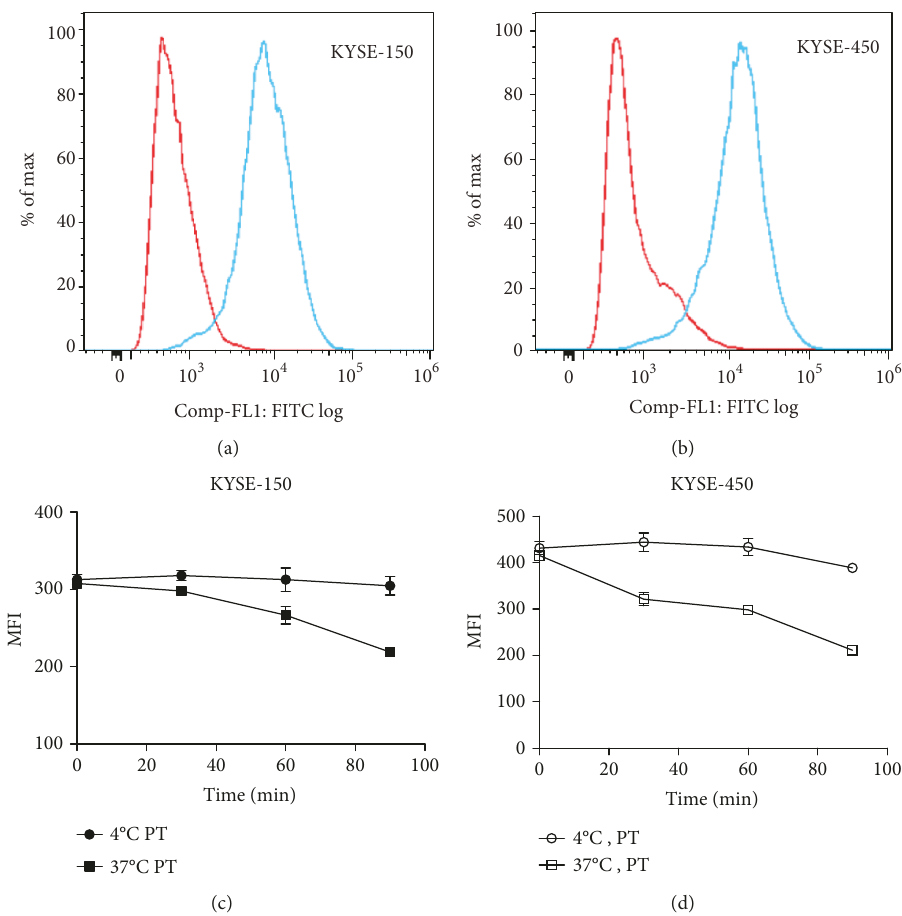
Figure 2: PT was rapidly internalized when bound to EGFR-overexpressed esophageal cancer cells. (a) Flow cytometric results, indicating cell surface EGFR expression in KYSE-150 cell lines. (b) Flow cytometric results, indicating cell surface EGFR expression in KYSE-450 cell lines. (c) Analysis of internalization rates of PT in KYSE-150 cells when binding to EGFR. (d) Analysis of internalization rates of PT in KYSE-450 cells when binding to EGFR. KYSE-150 or KYSE-450 cells were incubated with saturating level of PT (10 μ g/mL) for 30 minutes at 4 ° C. Unbound antibody conjugates were removed by washing cells. Cells were then incubated at either 4 ° C or 37 ° C. At the indicated time points, samples were detected by fl ow cytometry. Points: mean of 3 independent determinations; bars: